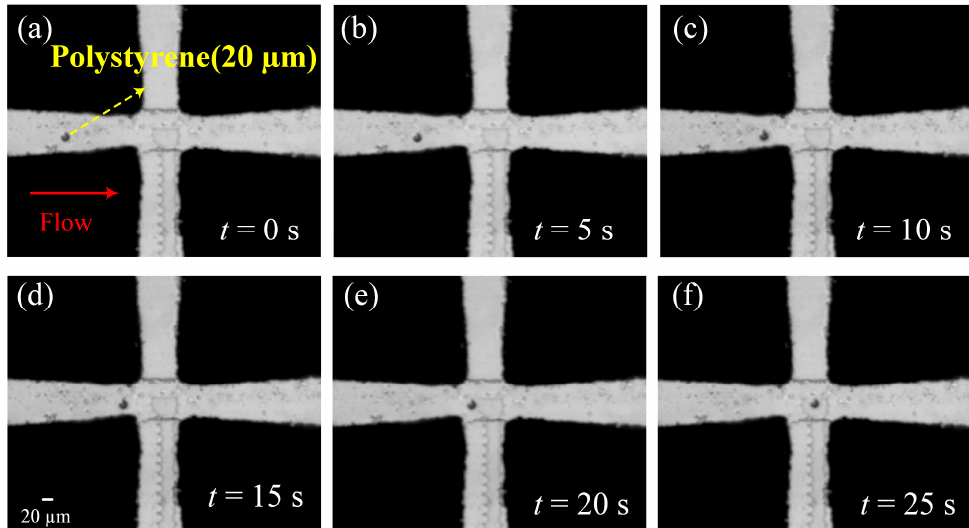
Figure 9. A 20 µ m polystyrene particle trapping experiment; ( a ) at 0 s, ( b ) at 5 s, ( c ) at 10 s, ( d ) at 15 s, ( e ) at 20 s, and ( f ) at 25